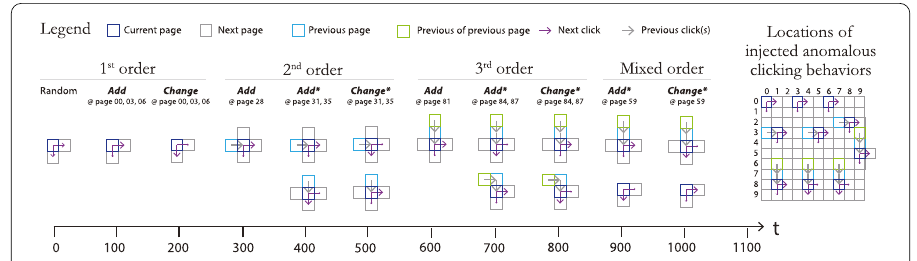
Figure 6 Synthetic taxi movement data: variable orders of navigation patterns on 100 cells as a 10 × 10 grid